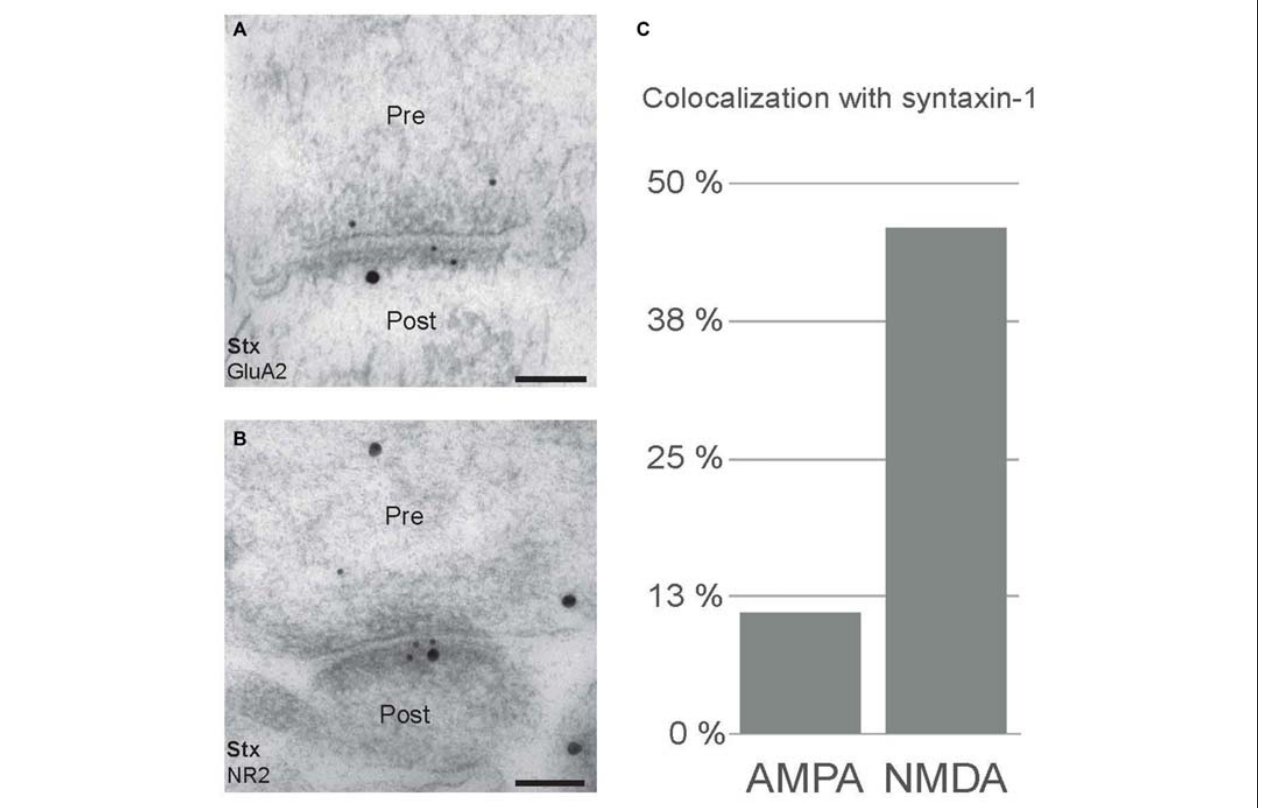
FIGURE 6 | Postsynaptic colocalization of syntaxin-1 and NMDA receptor subunits. (A) Double immunogold labeling of syntaxin-1 (20 nm) and AMPA receptor subunit, GluA2 (10 nm). (B) Electron micrographs showing colocalization of syntaxin-1 (20 nm) and NMDA receptor subunit, NR2B (10 nm). Scale bars: (A,B) 100 nm. (C) Quantitative analysis of colocalization between syntaxin-1/GluA2 and syntaxin-1/NR2B in